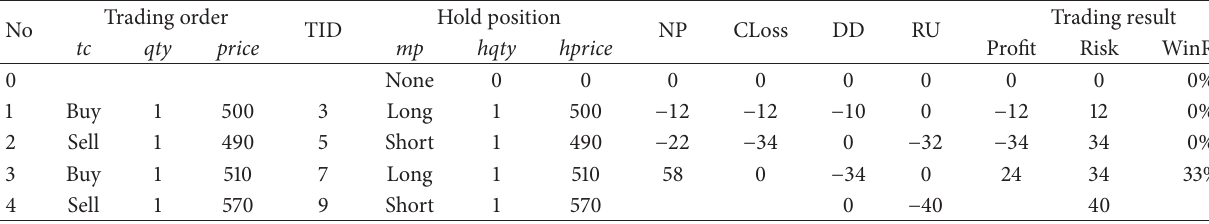
Table 2: The simulated trading of the rule { BF ,𝑎(0)𝑐(−1),𝑏(0)} .